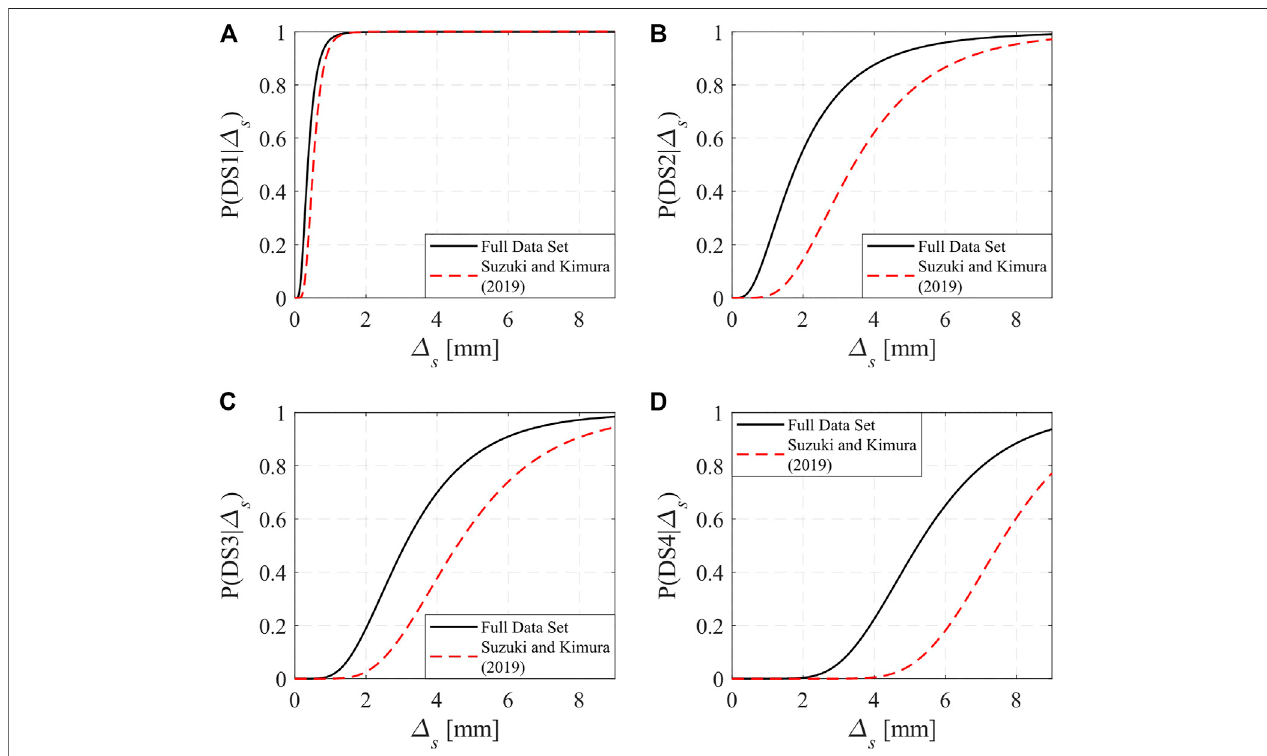
FIGURE7 | Comparison between fragility functions of steel beam-slab connections derived from the fulldataset and those derived from Suzukiand Kimura (2019) subset. (A) DS1 (B) DS2 (C) DS3 and (D) DS4.